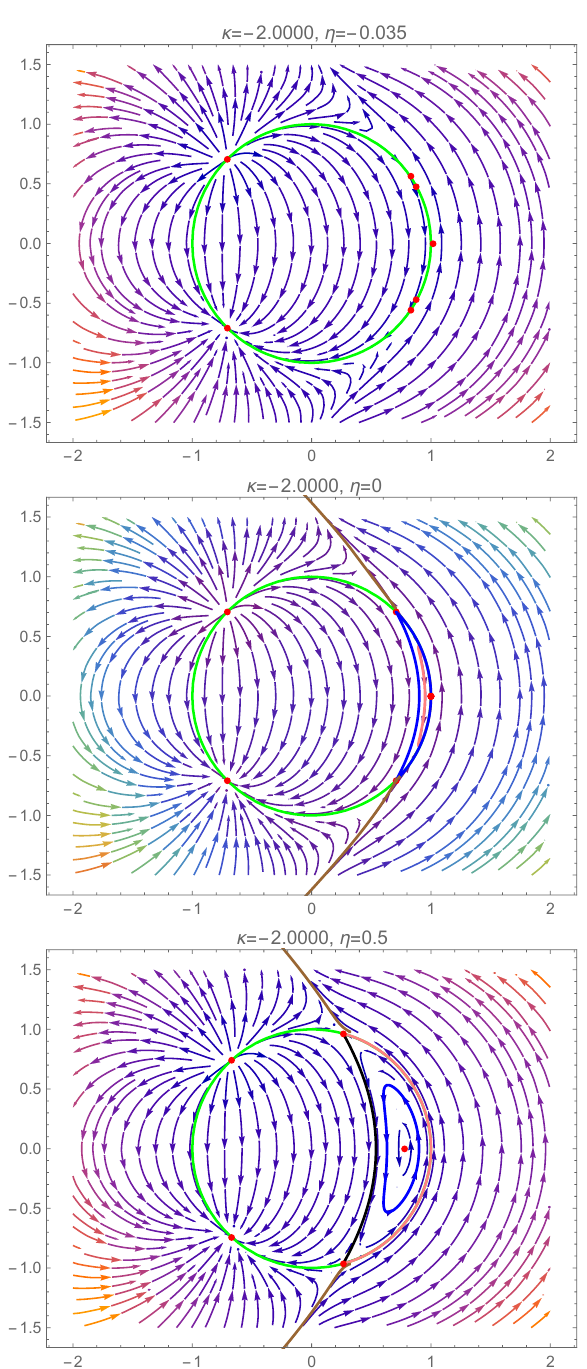
Figure 5. Phase portraits of system (7) and (8) inside and outside of the unit circle (the green curve) and outside it, for κ = − 2. Several homoclinic and heteroclinic orbits are presented (the black, blue, brown and pink curves). A detailed description is given in Section